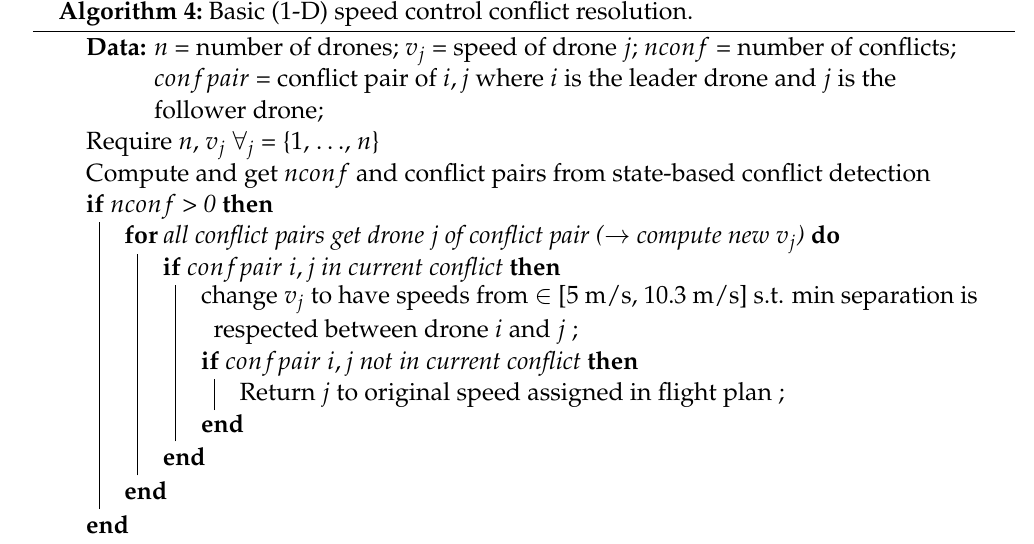
Algorithm 4: Basic (1-D) speed control conflict